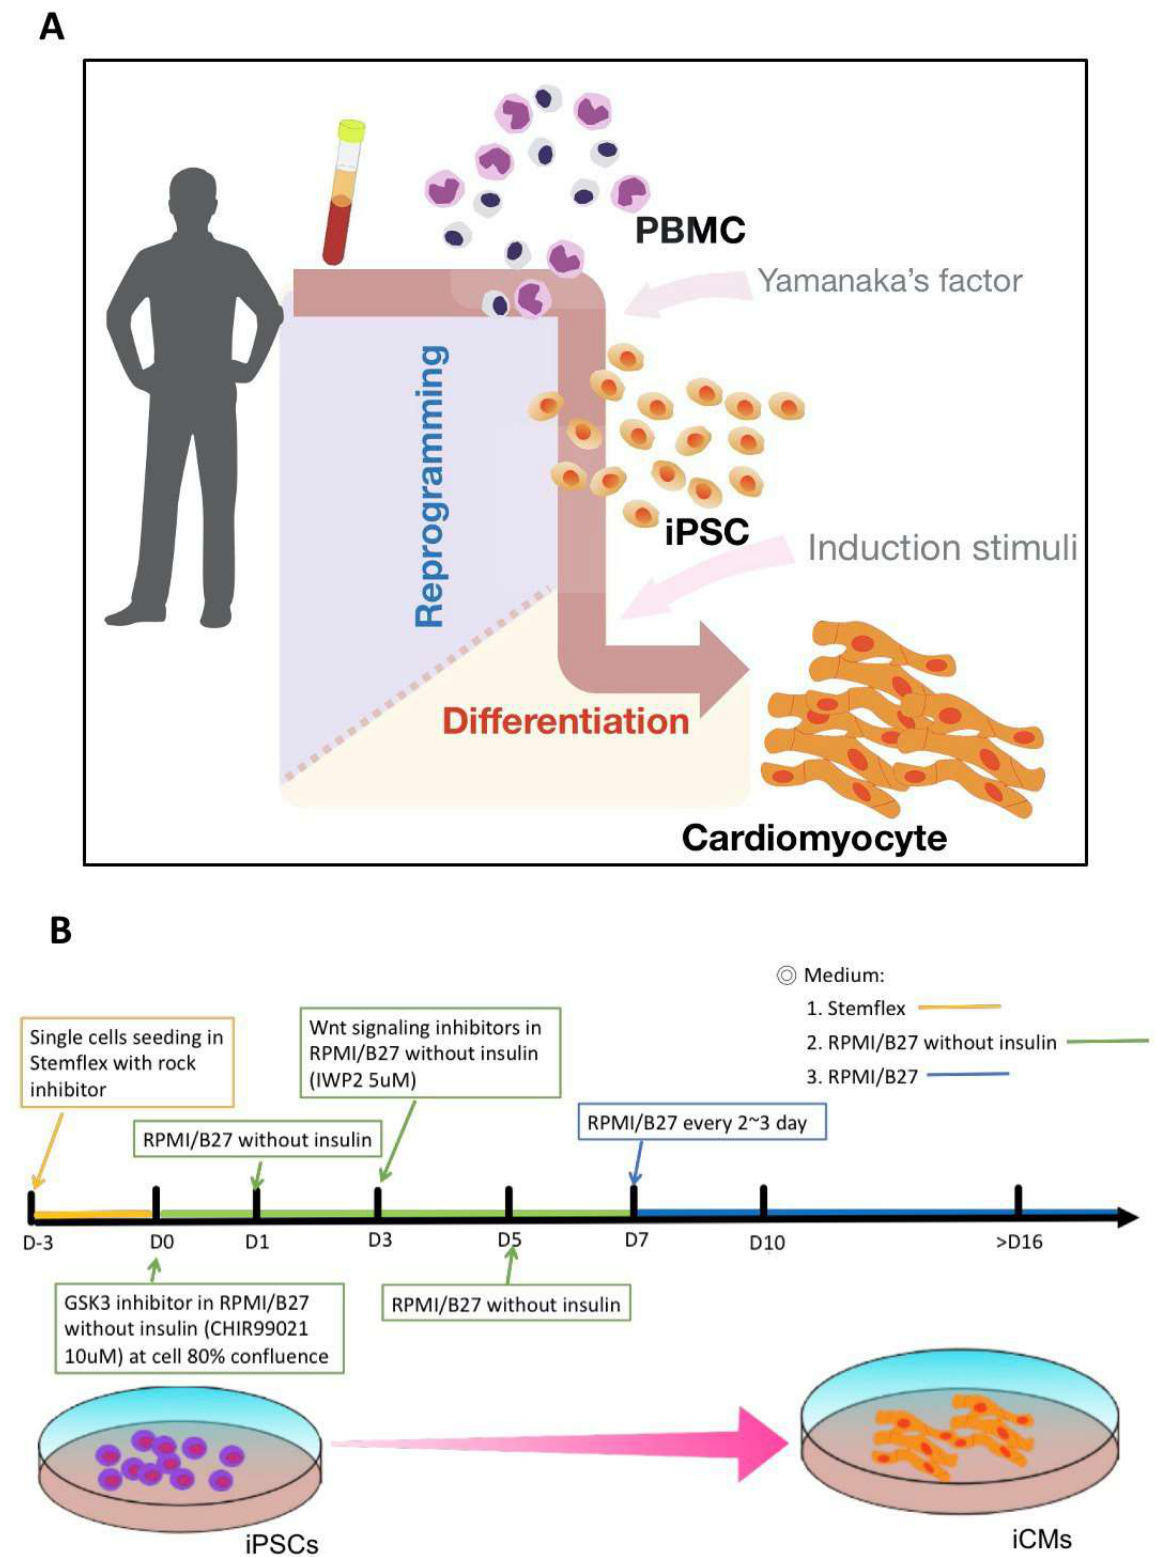
Figure 1. Schemes for hiPSC generation and the differentiation of iCMs. ( A ) Peripheral blood mononuclear cells (PBMCs) were reprogrammed into hiPSCs via transducing the Yamanaka’s factors, Oct4, Sox2, Klf4, and c-Myc. The resulting hiPSCs were then subjected to cardiac induction. ( B ) Functional mature iCMs with beating characteristics can be obtained at 16 days post-induction using the defined protocol of cardiac induction.